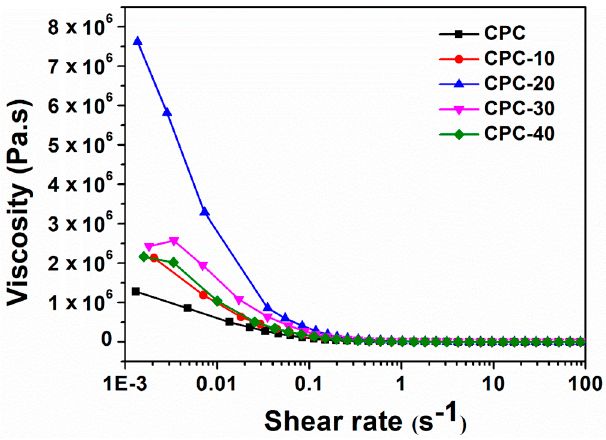
Figure 5. The viscosity versus shear rate behavior of CPC and PLGA-PEG-PLGA/CPCs at 37 °C.